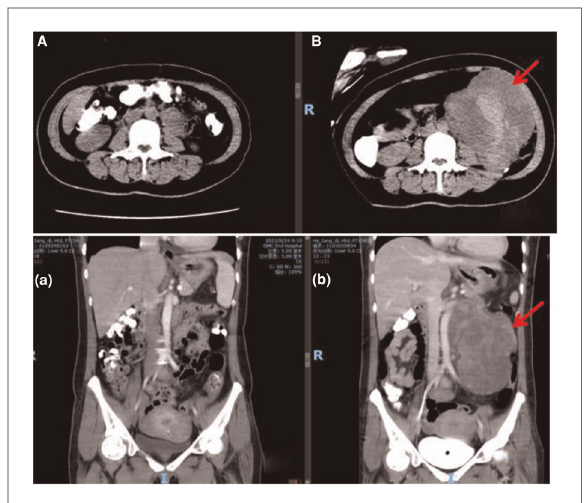
FIGURE 3 Abdominal CT comparison. ( A/a ) postoperative CT at fi ve months; ( B/b ) preoperative CT (arrow refers to the